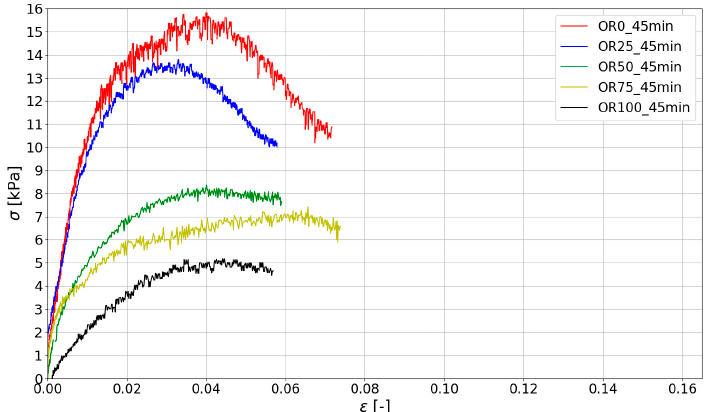
Figure 11. Stress–strain curves for mixes at 30 min after adding water.